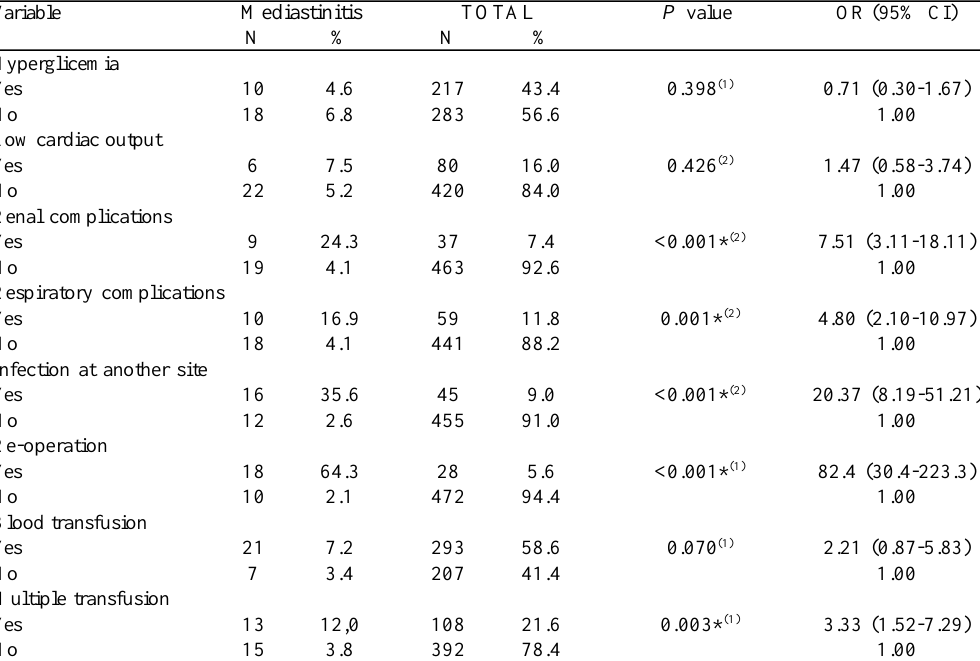
Table 3. Incidence of mediastinitis according to postoperative variables